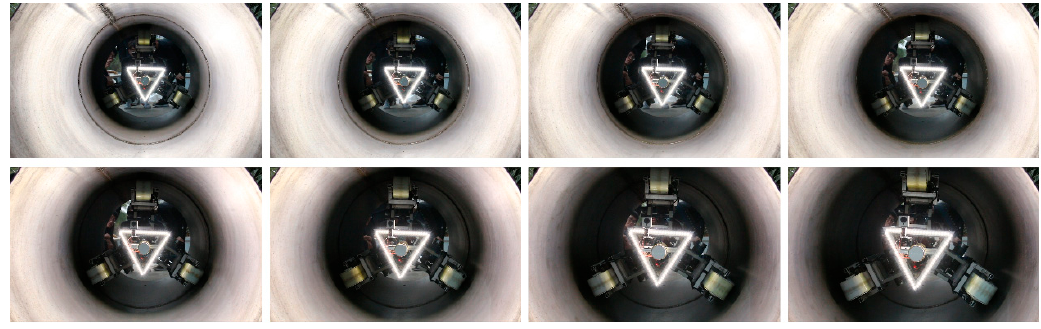
Figure 15. Straight driving experiment (every 3 s).